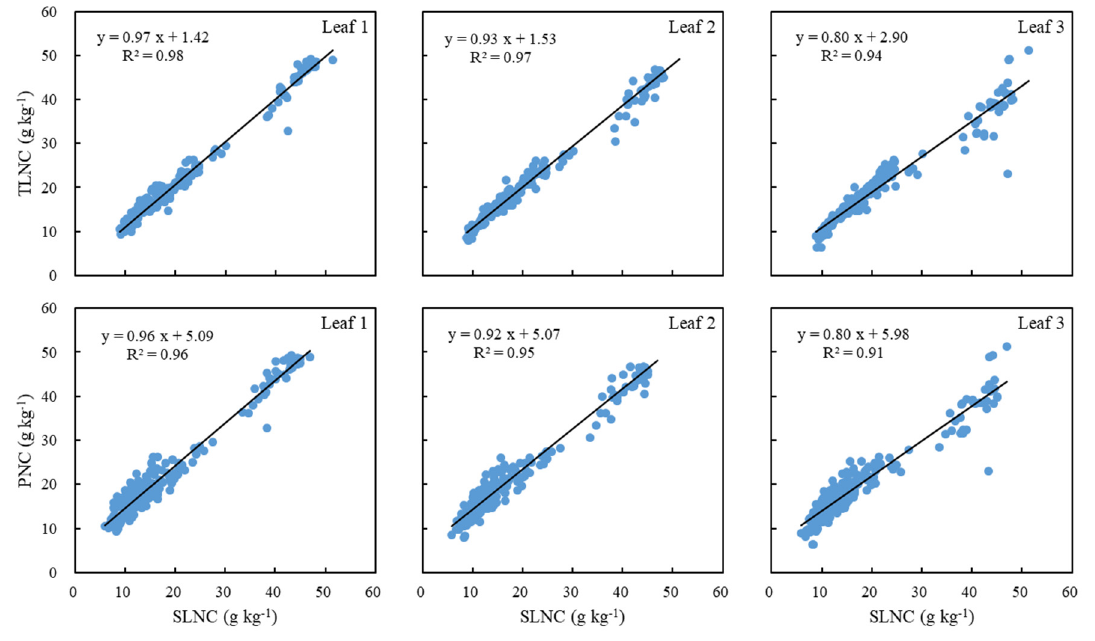
Figure 2. Relationships between single leaf N concentration (SLNC) obtained from three di ff erent leaves of a plant and total leaf N concentration (TLNC) and plant N concentration (PNC).